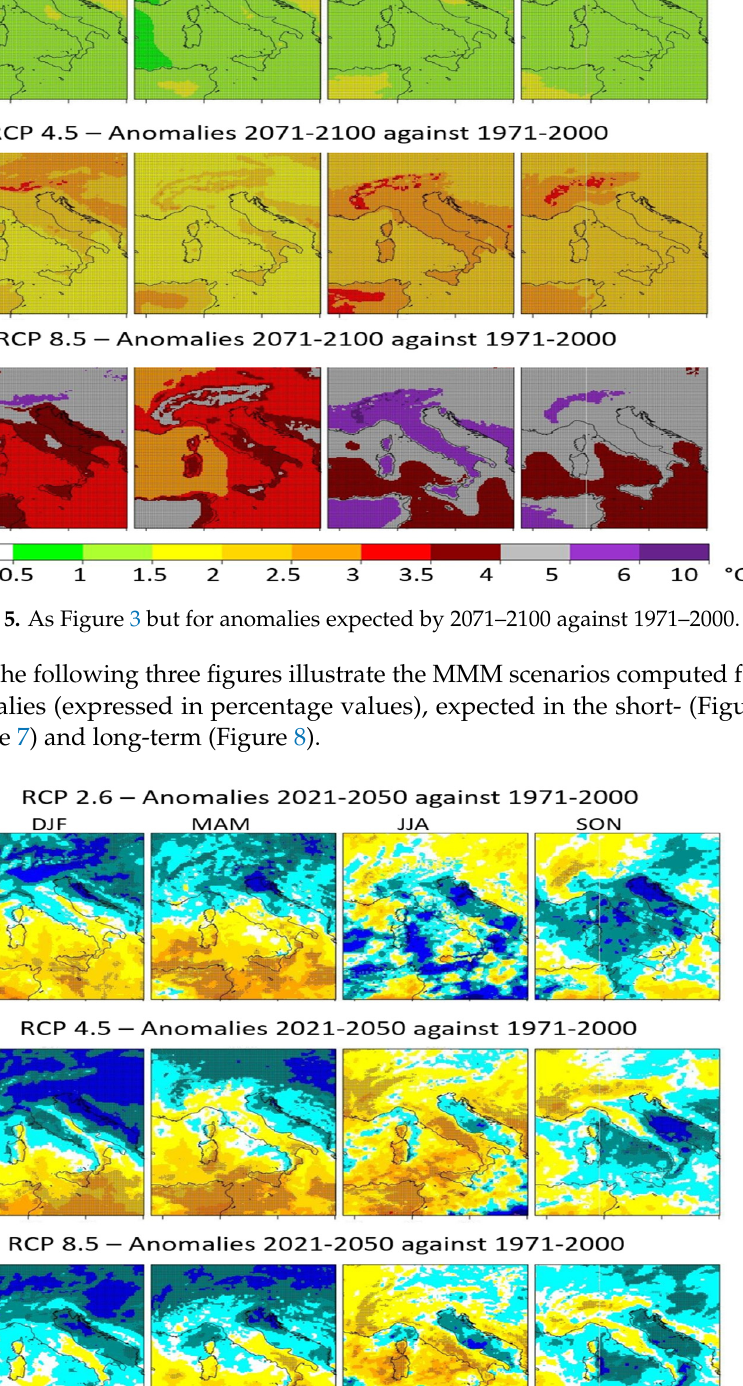
Figure 4. As Figure 3 but for anomalies expected by 2041–2070 against 1971–2000.